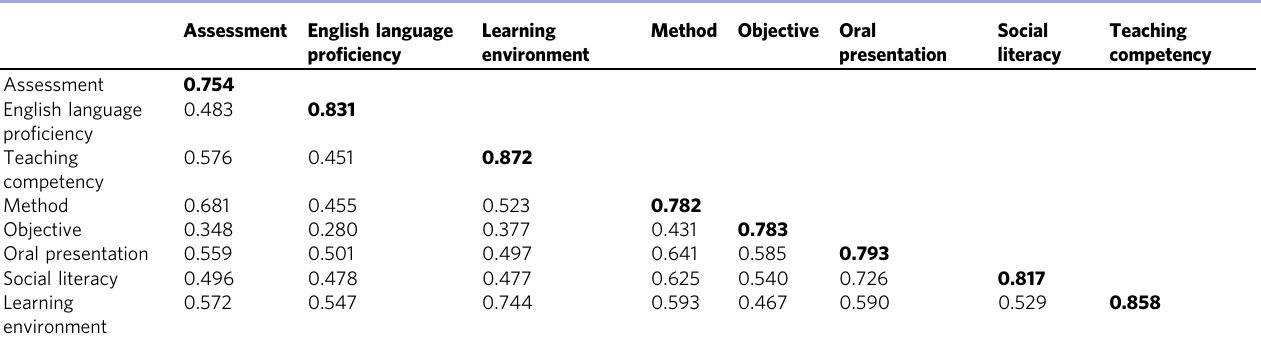
Table 8 The Fornell and Larcker ’ s (1981) criterion analysis for the measurement model.